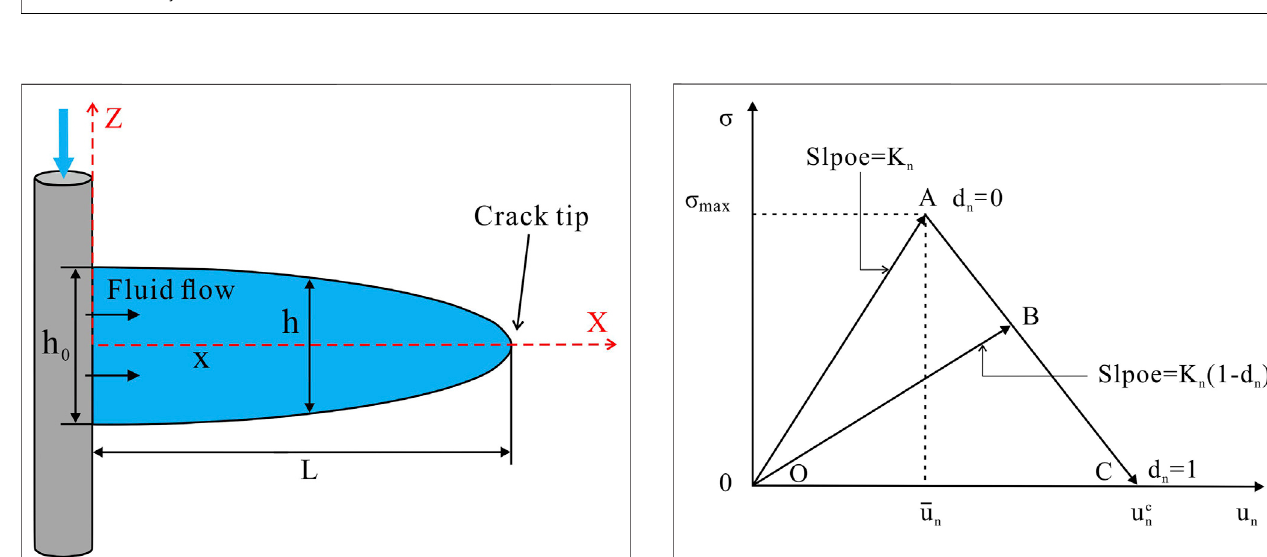
FIGURE1|(A) Mapshowinglocation andstructure outlineofthestudyareaintheeasternYunnan province. (B) Thelithology column ofthecoal measurestrataof Well-1 in the study area.